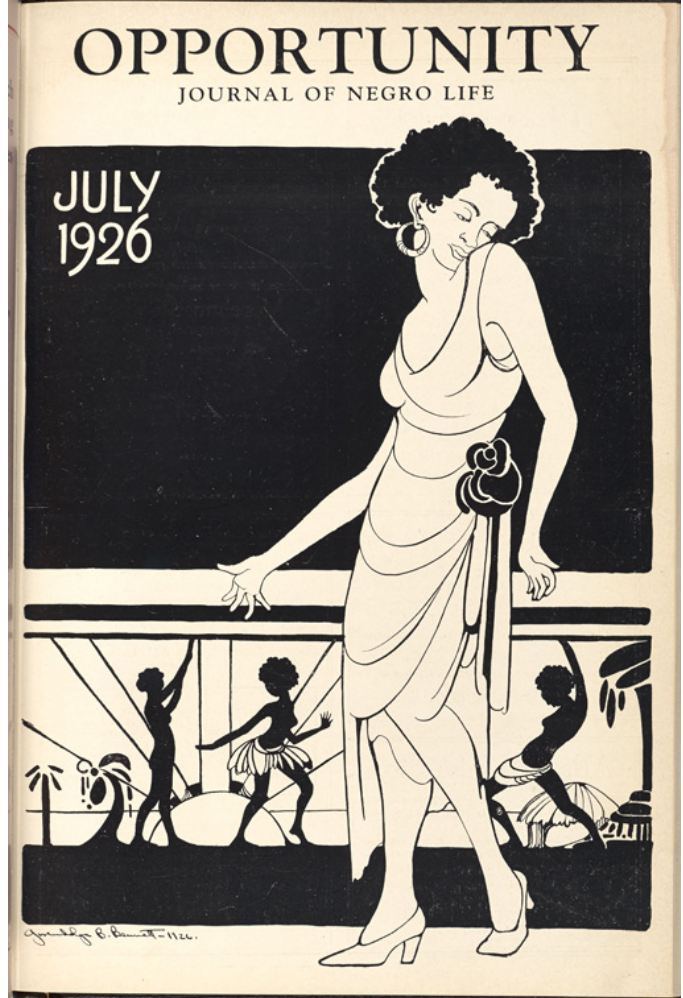
Figure 3. Gwendolyn Bennett, cover illustration, Opportunity: A Journal of Negro Life , July 1926. Schomburg Center for Research in Black Culture, Jean Blackwell Hutson Research and